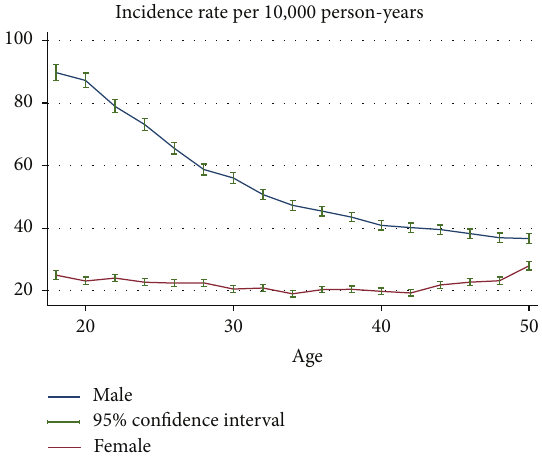
Figure 1: Gender-age-specific incidence rates of fracture hospitali- sation.